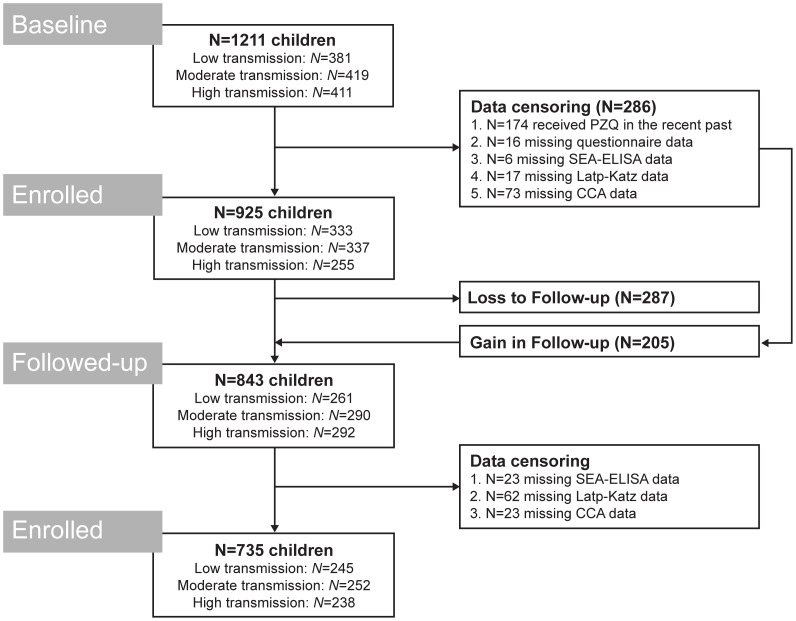
Flowchart detailing the study participation and adherence to sample submissions for diagnosis of S. mansoni.According to single Kato-Katz thick smear examinations, the prevalence of S. mansoni in preschool children living in the high, moderate and low transmission settings was 7.2%, 16.9% and 38.8%, respectively. Study was conducted in October/November 2009 and 2010.